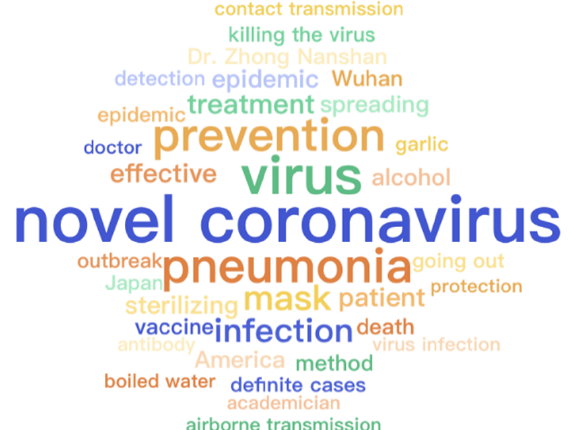
Figure 4. Word cloud of records labeled as questionable in the infodemic 2019 dataset.